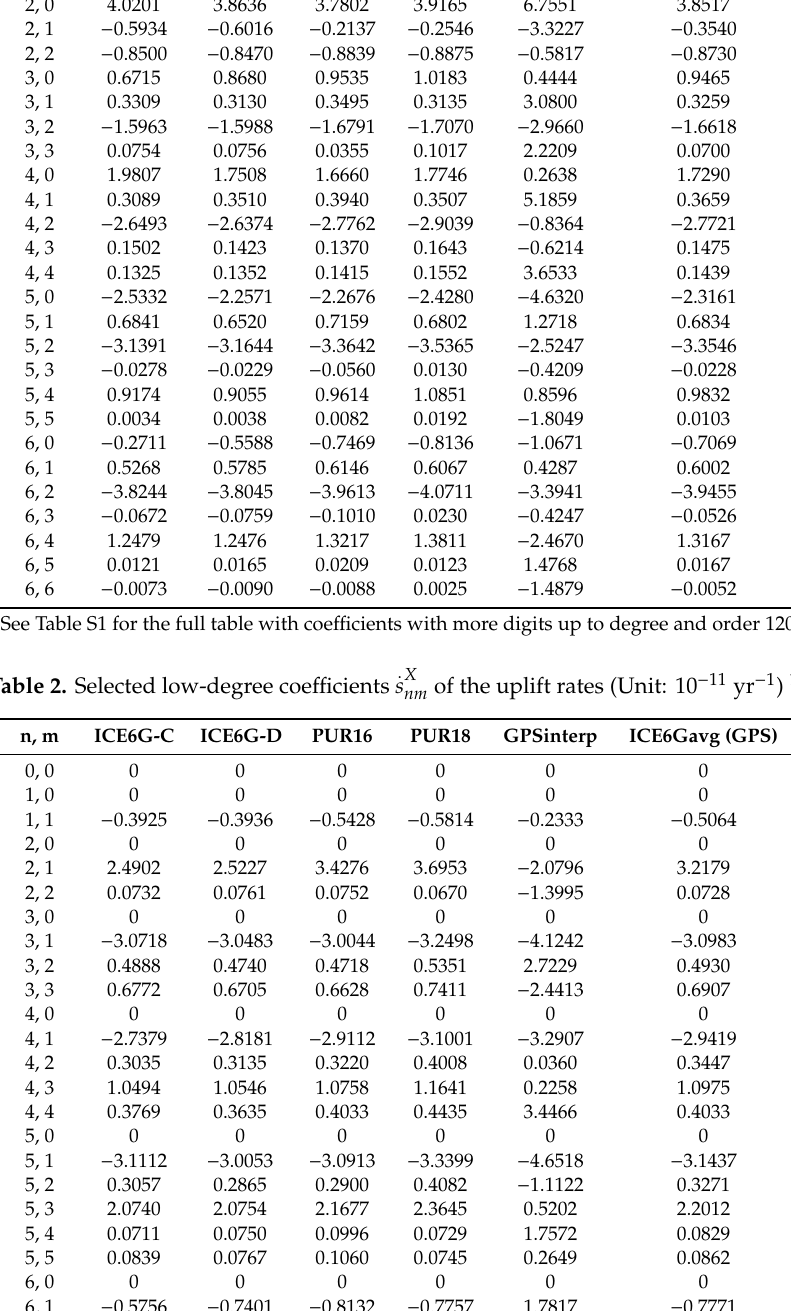
Table 1. Selected low-degree coe ffi cients